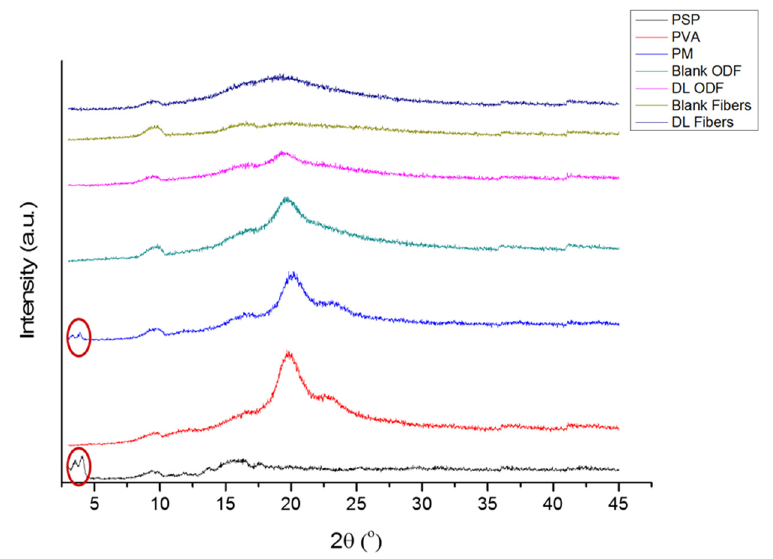
Figure 6. X-ray diffraction (XRD) patterns of PSP, PVA, PM, blank and drug-loaded nanofibers, and solvent-cast ODFs showing that PSP and PVP are in the crystalline form due to the presence of distinctive peaks between 3 and 5° and 18 and 21°, respectively. These peaks were also presented in the PM but not in the DL formulations, indicating the molecular dispersion of the drug within the nanofibers and ODFs. PM: physical mixture; DL: drug-loaded.